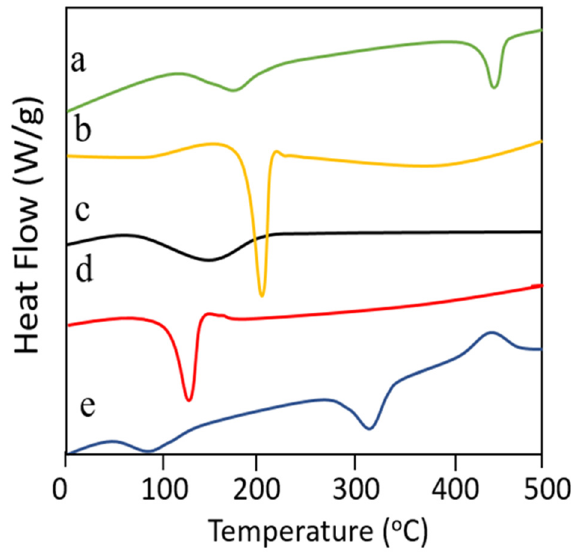
Figure 6. DSC thermograms of (a) PVA, (b) thiolated chitosan, (c) PVP-k30, (d) Simvastatin and (e) Simvastatin loaded dMNPs.